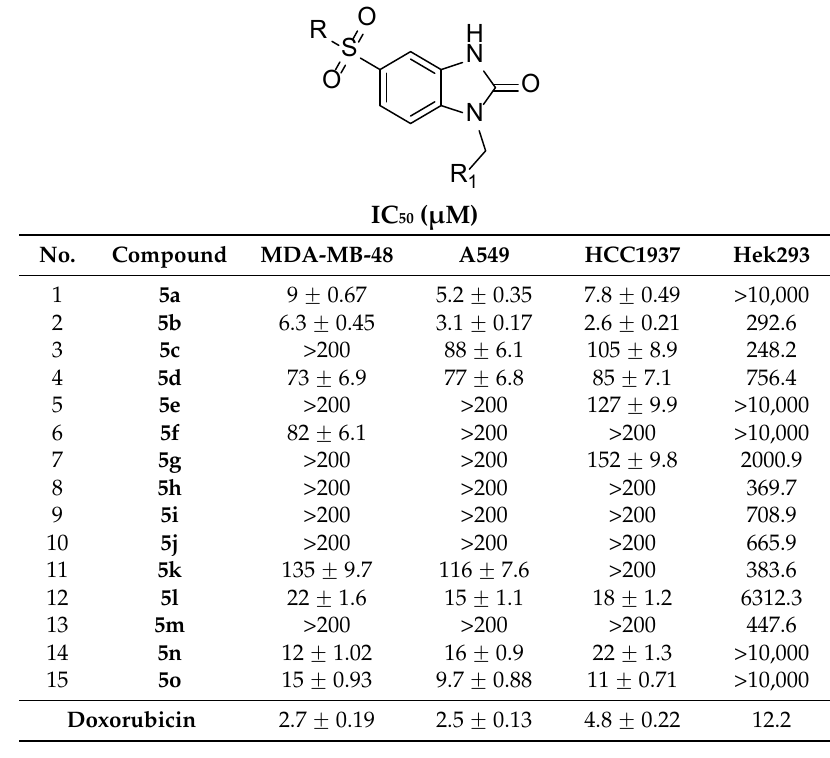
Table 1. In vitro cytotoxic activity of target compounds: 5a – o .